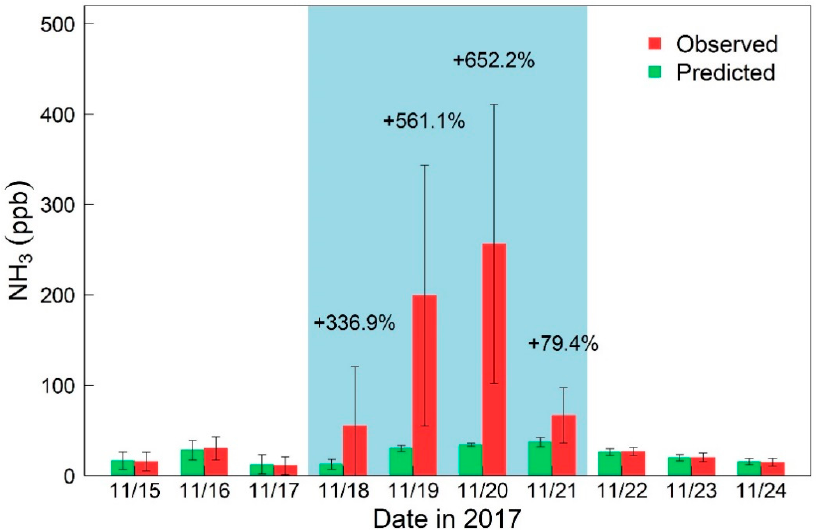
Figure 3. Observed and predicted concentrations of NH 3 before, during and after the burning period at the Xianghe site. Percentages on bars indicate relative changes ( R ) between the observed and predicted concentrations.